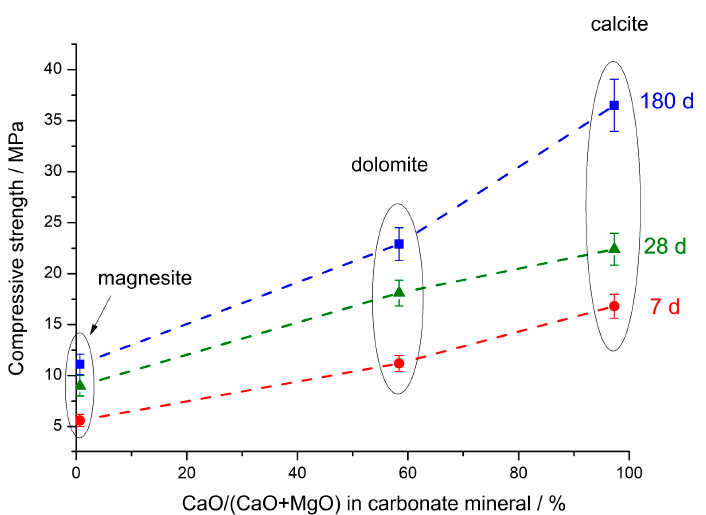
Figure 8. Effect of CaO/(CaO+MgO) content in carbonate minerals on the compressive strength of geopolymers based on (90% FA +10% carbonate) blends mechanically activated for 180 s and cured for 7, 28, and 180 days.